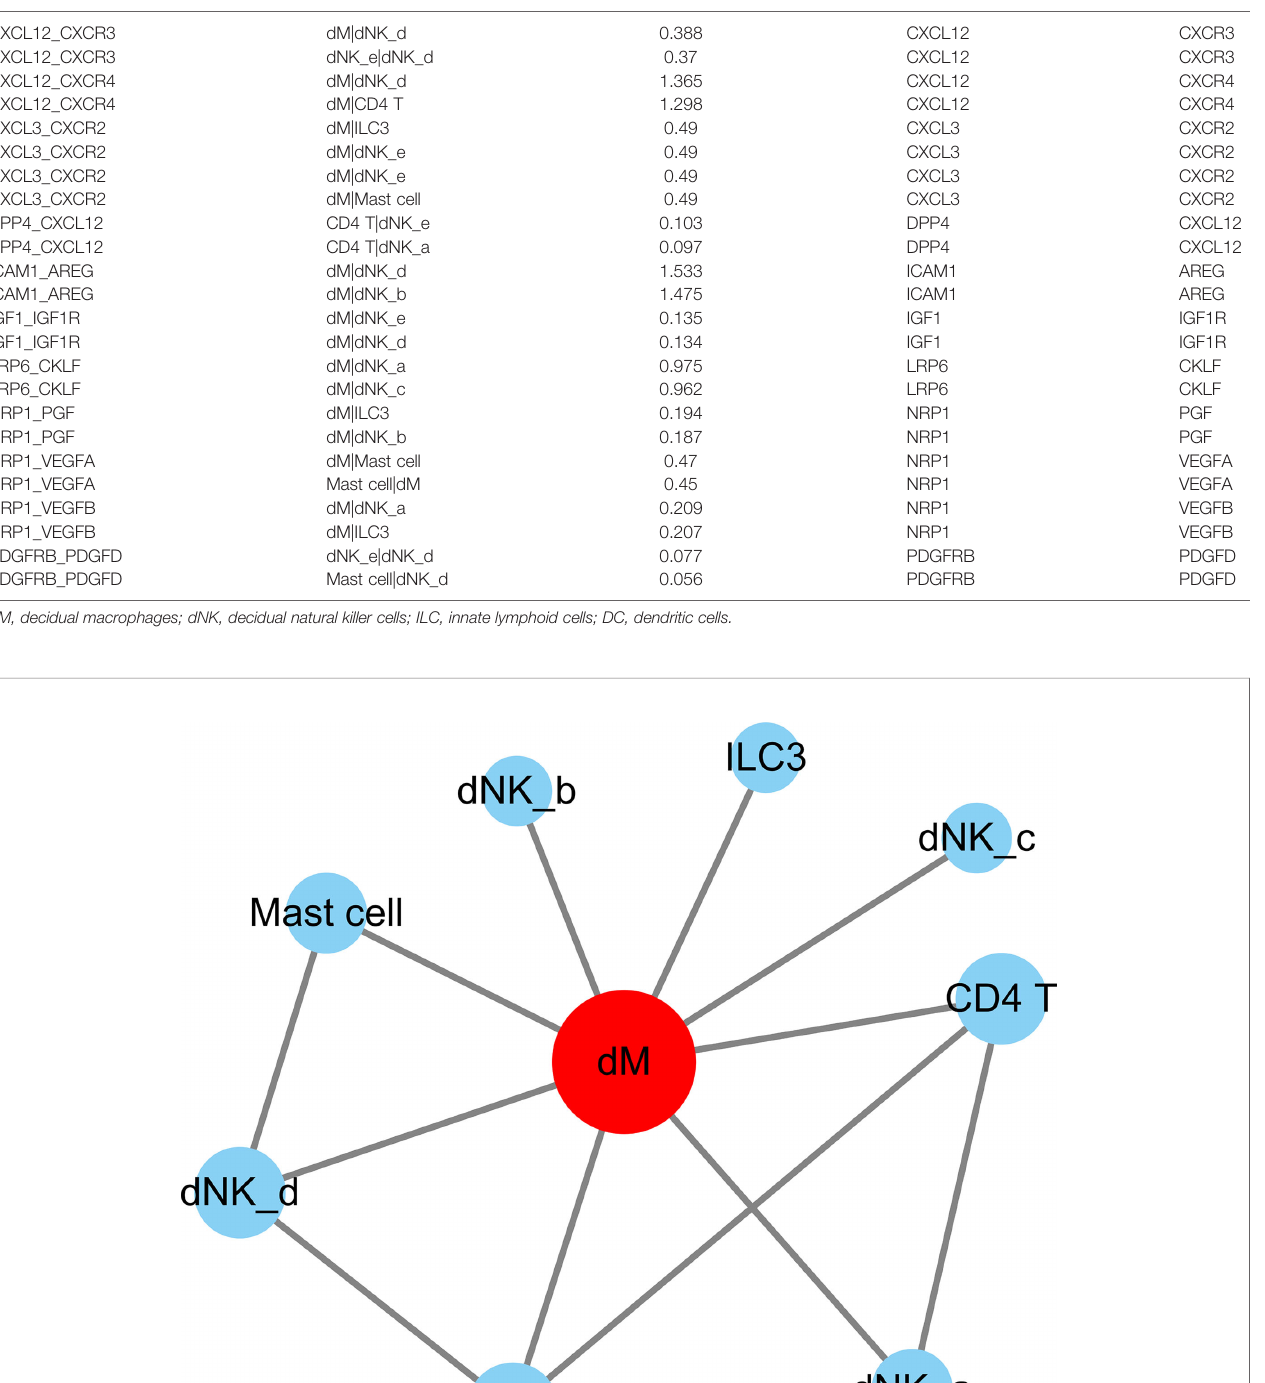
TABLE 1 | The cell-to-cell interactions of differentially expressed genes involved. inter